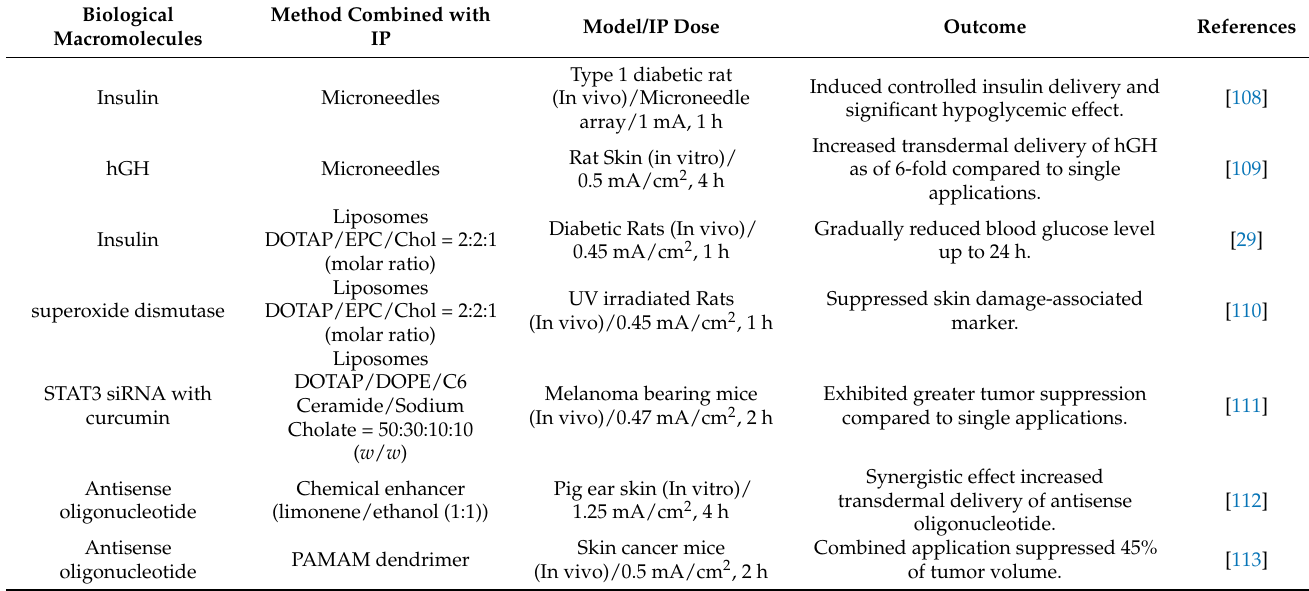
Table 3. Combined application of IP with other permeation